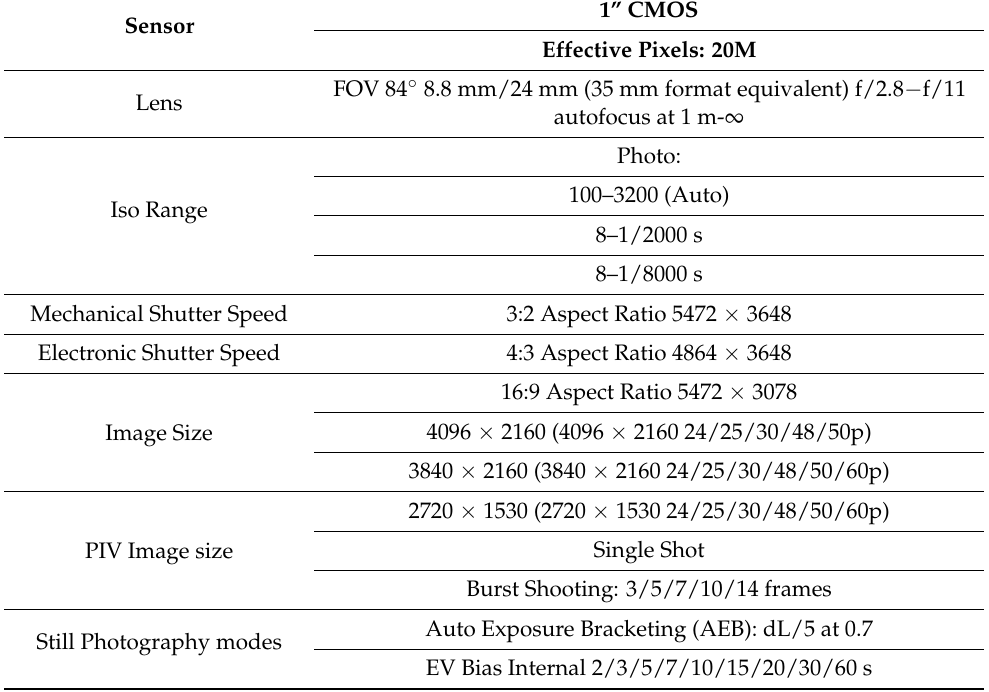
Table 2. Data of